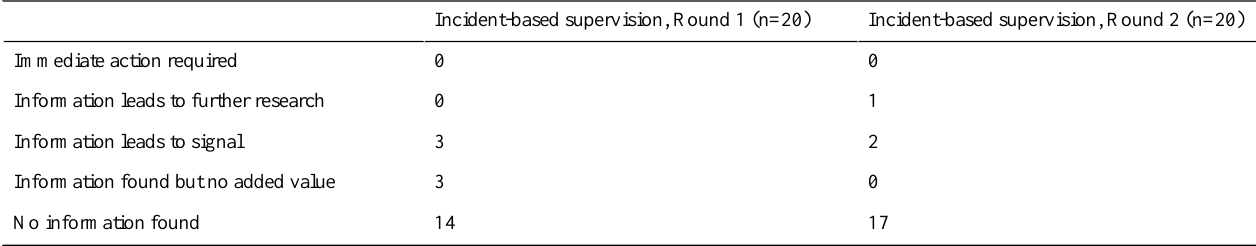
Table 1. Added value of information for incident-based